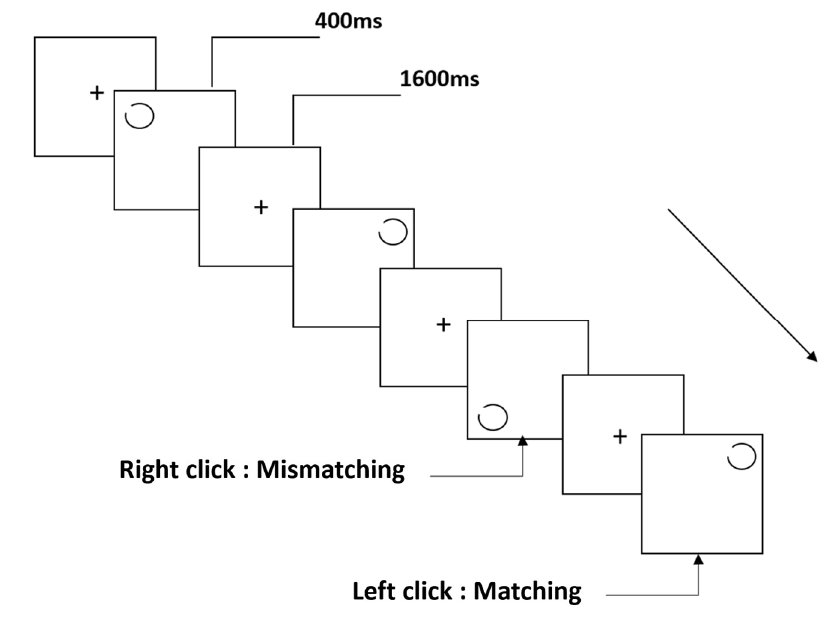
Figure 1. Schematic diagram of the notch circle task.